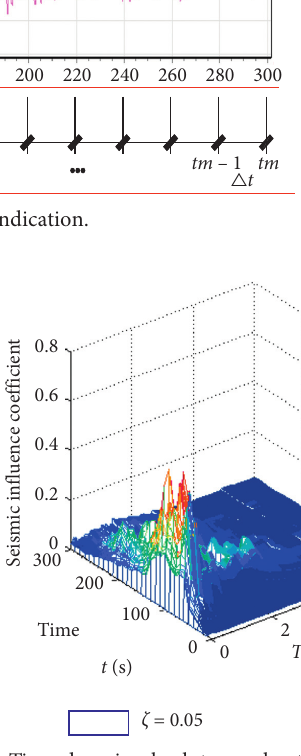
Figure 6: Time-domain absolute acceleration elastoplastic influ- ence coefficient surface (time interval 10s).